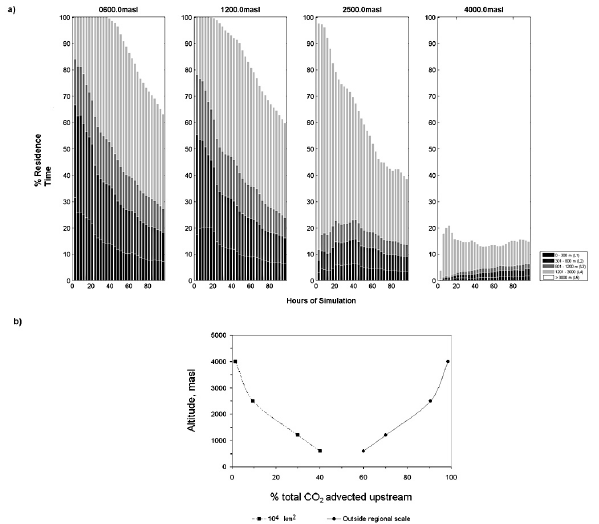
Fig. 2. (a) Temporal distribution of the percentage of Residence Time (R t ) at each 3h time step at different layers of the low tropo- sphere (0–300 or L1, 301–800 or L2, 801–1200 or L3, 1201–3000 or L4 and above 3000ma.g.l., L5) for simulations started at 600, 1200, 2500 and 4000ma.s.l. (b) Vertical distribution of the per- centage of the regional surface influence (10 4 km 2 ) and outside the regional domain for the CO 2 vertical profiles belonging to the Liny- ola’s